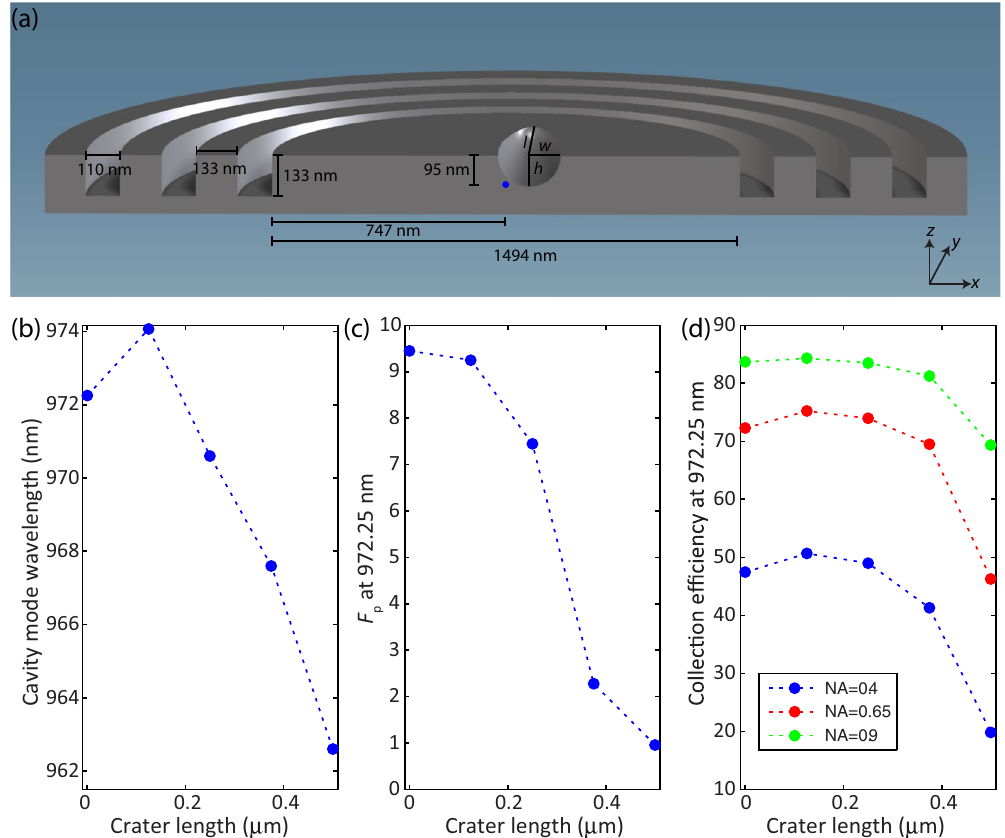
Figure 5. Finite-Difference Time-Domain simulations of the optical properties of a circular grating cavity containing a quantum dot and a crater-like feature close to its center. ( a ): Geometry of the simulated sample: the quantum dot (blue sphere) is positioned in the center of the circular grating structure. The center position of the half-ellipsoidal crater, used to depict a surface morphological (crater-like) feature, is fixed at a position x = 75 nm, y = 0 nm, z = 95 nm with respect to the QD. The crater width w is kept fixed at 125 nm, while the crater length l and crater height h have a fixed aspect ratio of 5:1, with the length l varying between 125 nm and 500 nm. The leftmost point (crater length = 0) corresponds to the circular grating structure in absence of a crater. Finite-difference time-domain simulations of the circular grating cavity wavelength (panel (b)), the Purcell factor F p (panel (c)) and collection efficiency of the QD emission into objectives with different numerical aperture (NA) (panel (d)), plotted as a function of crater